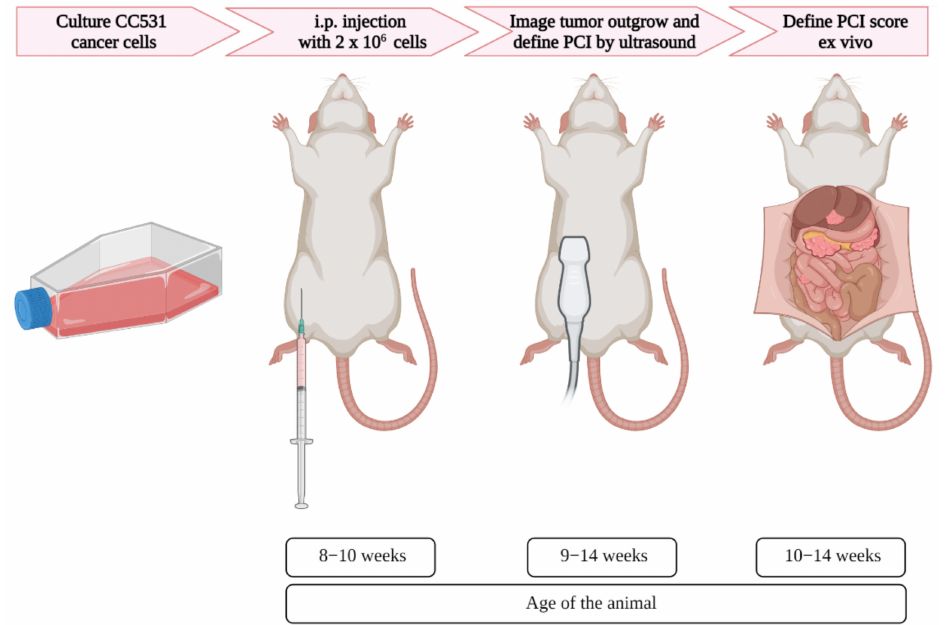
Figure 1. Schematic overview of the induction and imaging of peritoneal metastases in rats, with corresponding age. After the appropriate number of colorectal cancer cells were cultured, the cells were injected in the intraperitoneal area of the rats. Using ultrasound, the tumor formation was assessed, and when tumors reached the size of 4–6 mm, the PCI was scored. Immediately after the last ultrasound imaging, the PCI score was defined ex